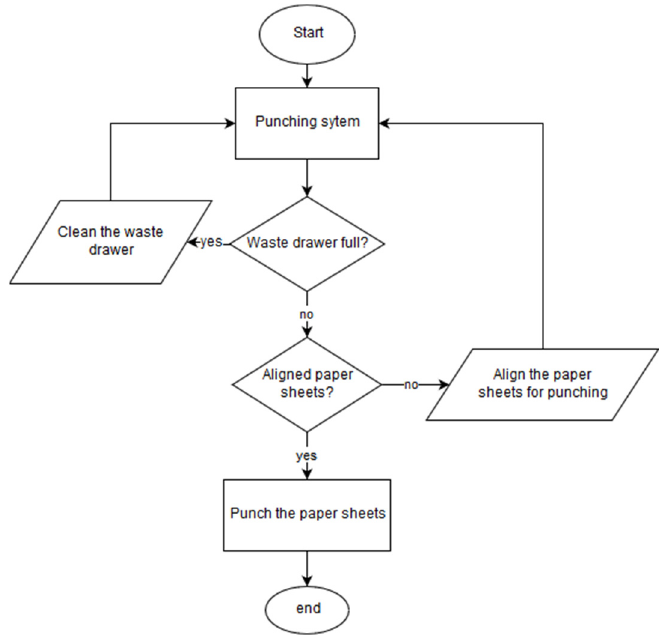
Figure 32. Block diagram for punching a block of sheets.